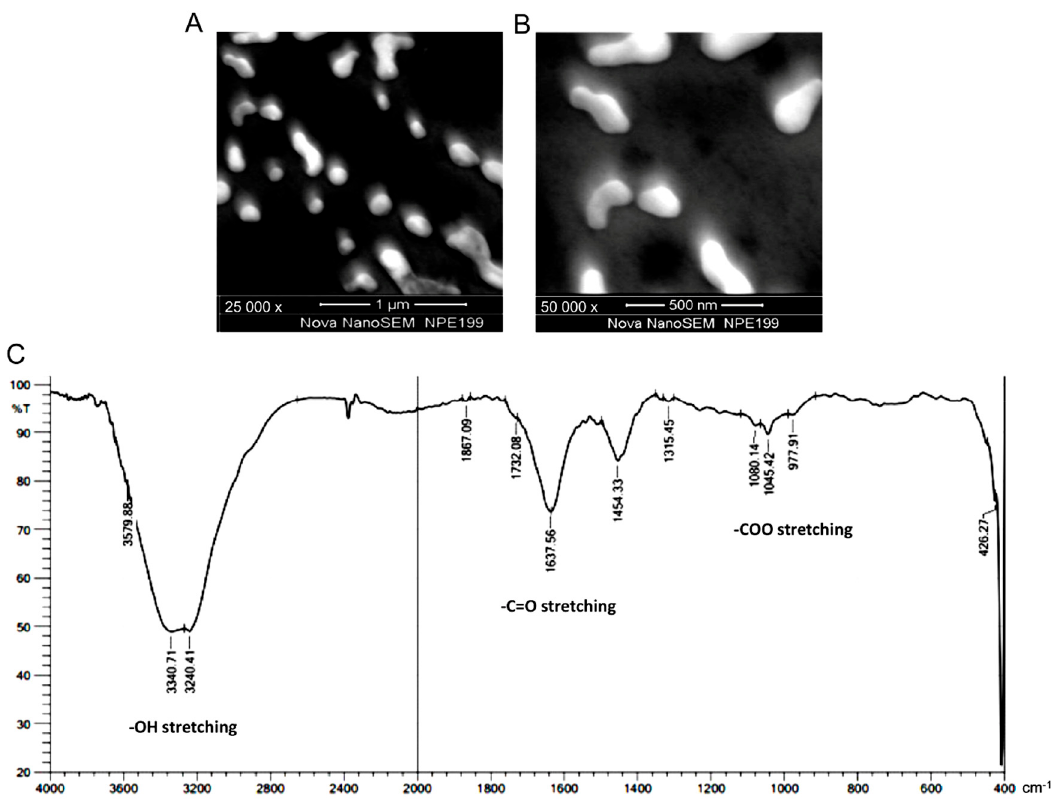
Figure 3. Nanomelanin particles under SEM at different magnifications of 25,000 × ( A ) and 50,000 × ( B ); and chemical functional groups detected on nanomelanin particles, measured by FTIR ( C ).